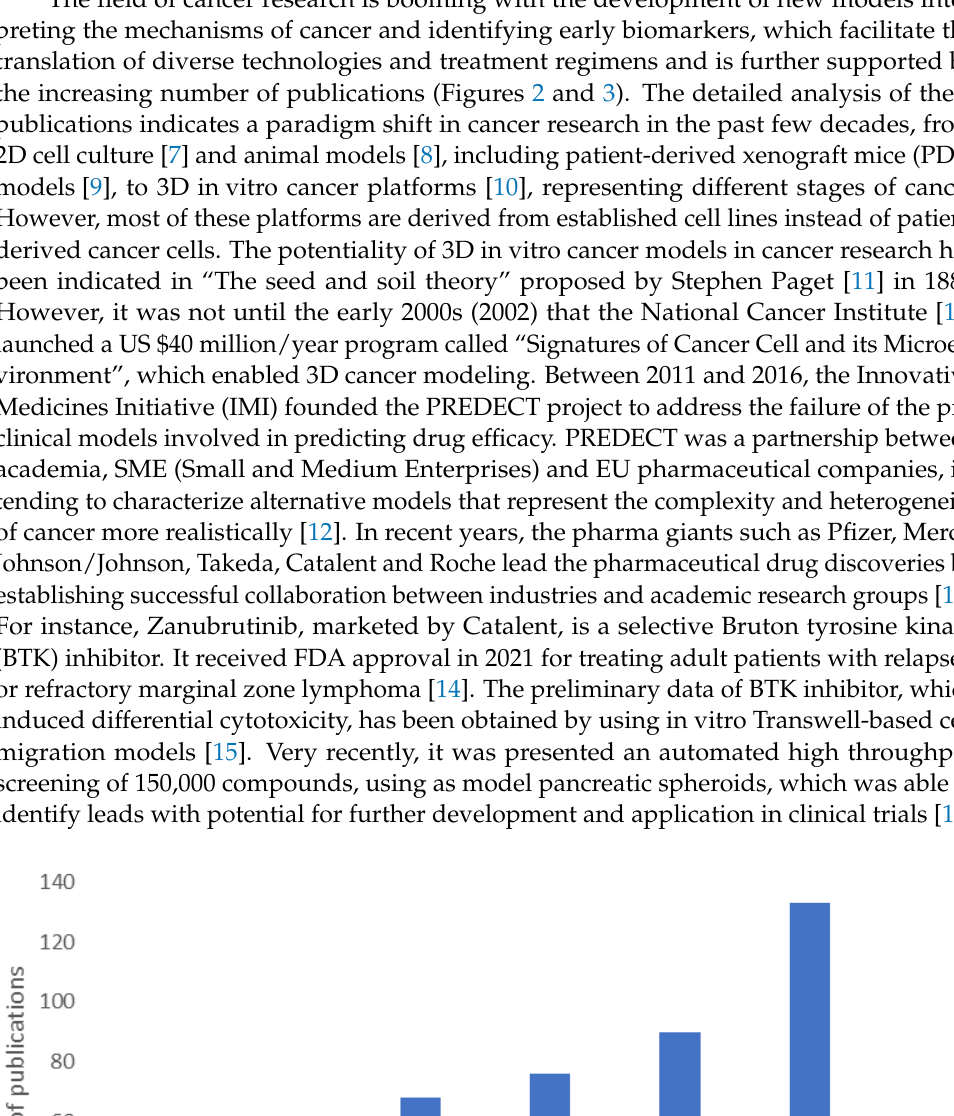
. Figure 3. Types of cancer that are represented in 3D models (from the search mentioned in Figure 2). In “others” are included thyroid, renal, gastric, mesothelioma, bladder, head and neck, and blood cancers. “Non-specific” refers to papers that use cells from different cancer types (different cell lines) or do not use cancer cells in the model. “Reviews” also include opinion papers and book chapters. While the forecasts for personalized cancer care are very promising, there is no single route that leads to a complete commercialized cancer model. Each pharmaceutical and biotechnological industry has its own focus to contribute to personalized cancer care, which is summarized in the following section of the review. 2. 3D Cancer Models: Product Segments, Commercial Tools, Prototypes, and Patents Looking back, the modelling of cancer using animals is more than 100 years old. The Ehrlich ascites tumor cells, the spontaneous murine mammary adenocarcinoma cells that rapidly grow in almost all mouse strains, are considered one of the most primitive cancer